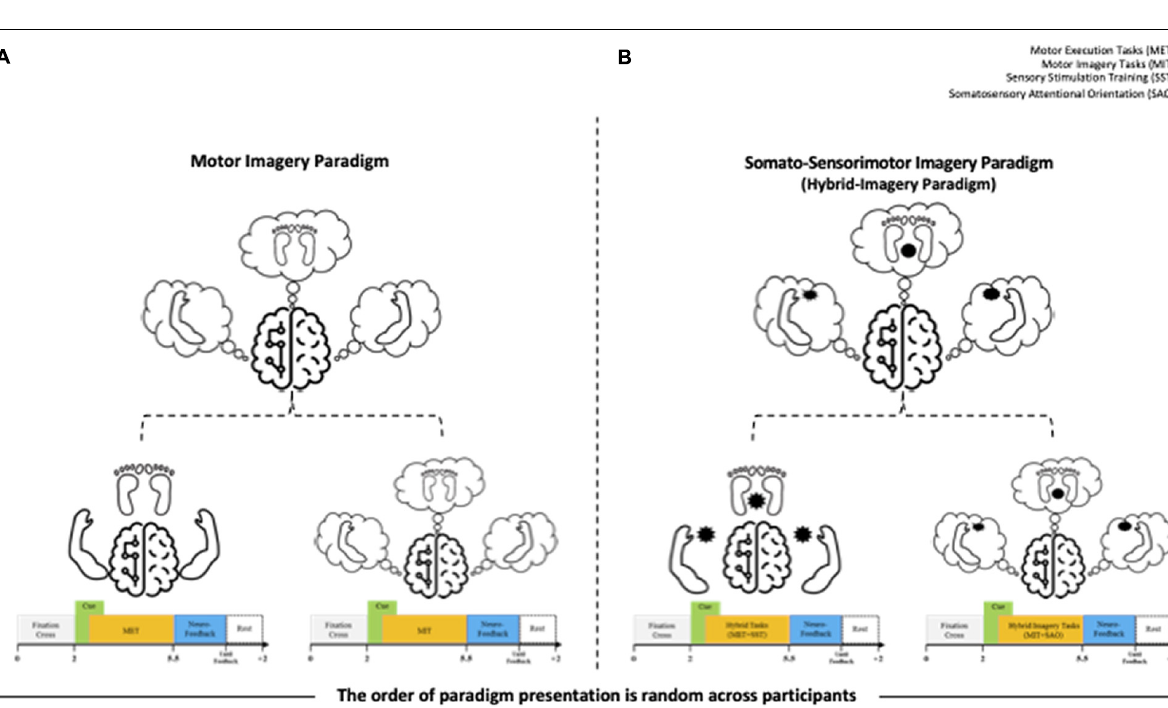
hand, right hand, and right foot, as shown in Figure 4B .